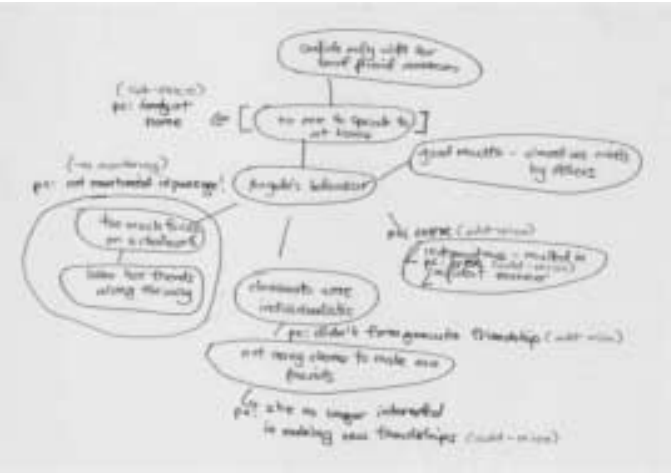
Figure 1. Sample showing peer comments coded using Faigley and Witte’s (1981) and Stark et al .’s (2002) categories. Note : pc refers to peer comments. Categorizations in parentheses refer to type of